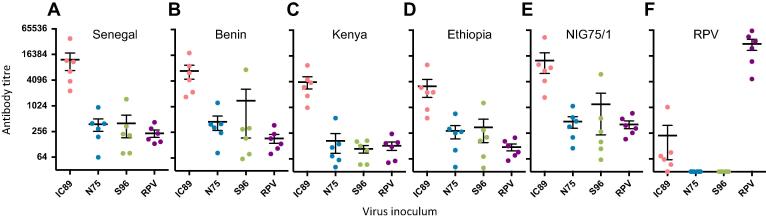
Neutralising antibody titres in cattle following PPRV or RPV inoculation. Four groups of six cattle were inoculated with PPRV/Ivory Coast/89 (IC89), PPRV/Nigeria/75/1 (N75), PPRV/Sungri/96 (S96) or RPV/RBOK (RPV). Sera were tested at 4 weeks post-infection for neutralising activity against VSV(PPRV) pseudotypes bearing the (A) Senegal 1969, (B) Benin 2010, (C) Kenya 2011, (D) Ethiopia 2010 or (E) Nigeria 75/1 strains of PPRV, or (F) Kabete O strain of RPV. Serial dilutions of each serum sample were prepared in triplicate and screened for neutralising activity against each VSV(PPRV) pseudotype. Antibody titres were calculated based on a 90% reduction of infectivity relative to the no serum control. Mean ± SEM (n = 6) is shown for each group.